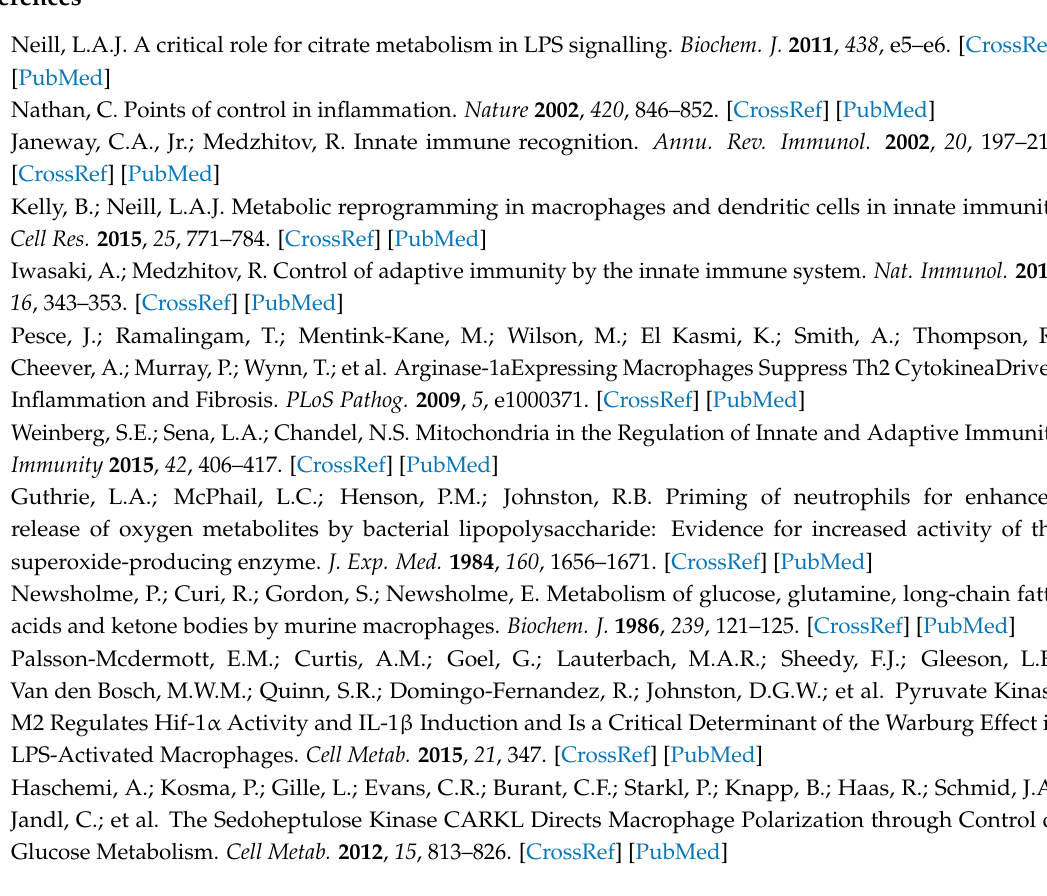
Figure S1: Showing MPLC separation of BV components, Figure S2: Microscopic comparison between negative control THP-1 cells and its derived macrophages, Figure S3–S14: Showing a representative 4-parameter logistic plot of TNF- α , IL-1 β , IL-6, and IL-10 standard samples, Figure S15: Extracted ion chromatograms for arachidonic acid, Table S1–S4: Effect of melittin on the production of TNF- α , IL-1 β , IL-6, and IL-10 cytokines in the presence and absence of LPS, Table S5: List of abbreviation, Table S6: List of catalog/serial number of instruments and